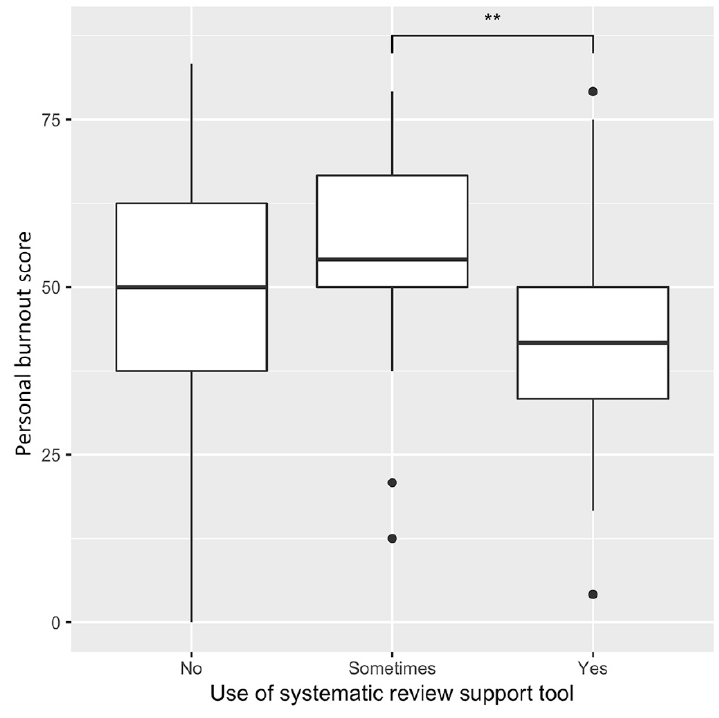
Figure 1 Personal burnout score depending on use of a systematic review (SR) support tool